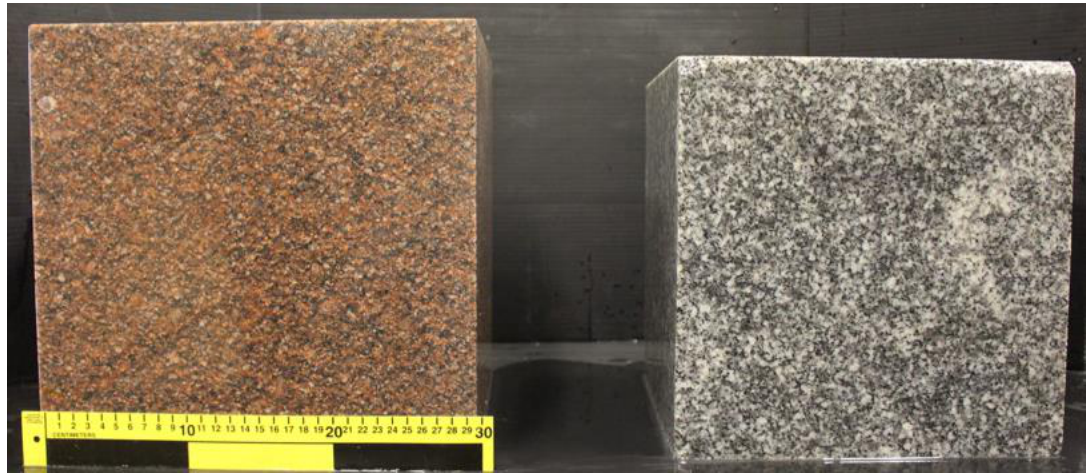
Figure 2. Cuboidal samples obtained from Lac du Bonnet granite (left) and the Stanstead granite (right).